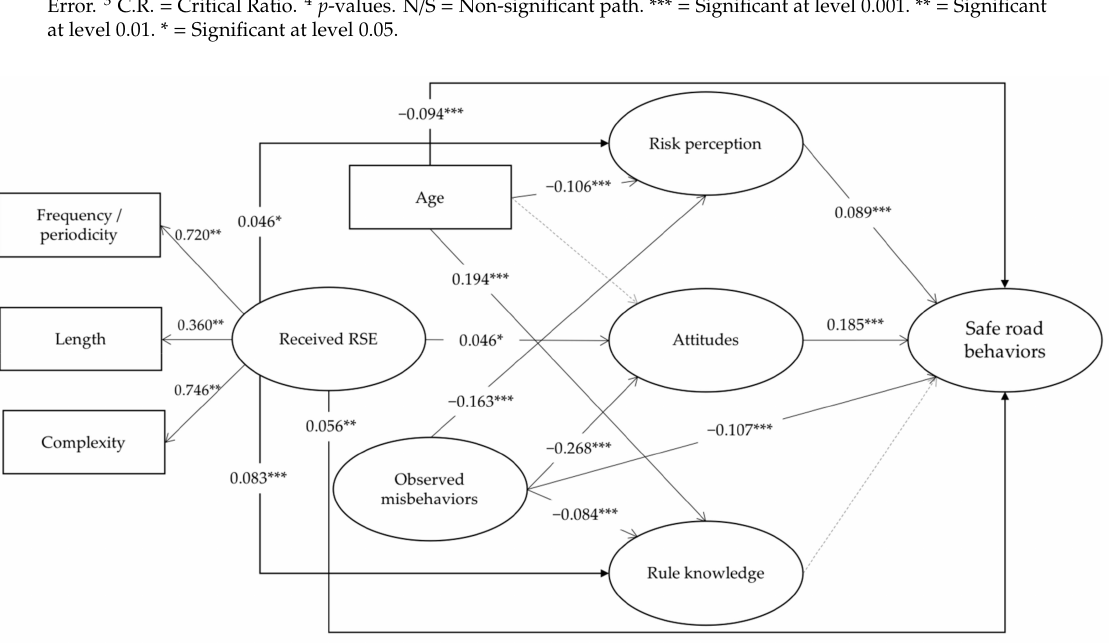
Figure 1. Path structural model presenting standardized path coe ffi cients for self-reported Safe (protective) Road Behaviors: * p < 0.05; ** p < 0.01; *** p < 0.001. Solid lines (arrows) represent significant paths and intermittent lines represent nonsignificant